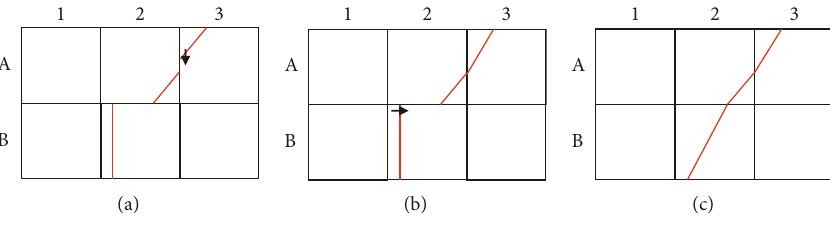
Figure 13: Applying the CMA, to make the crack mapping unify.